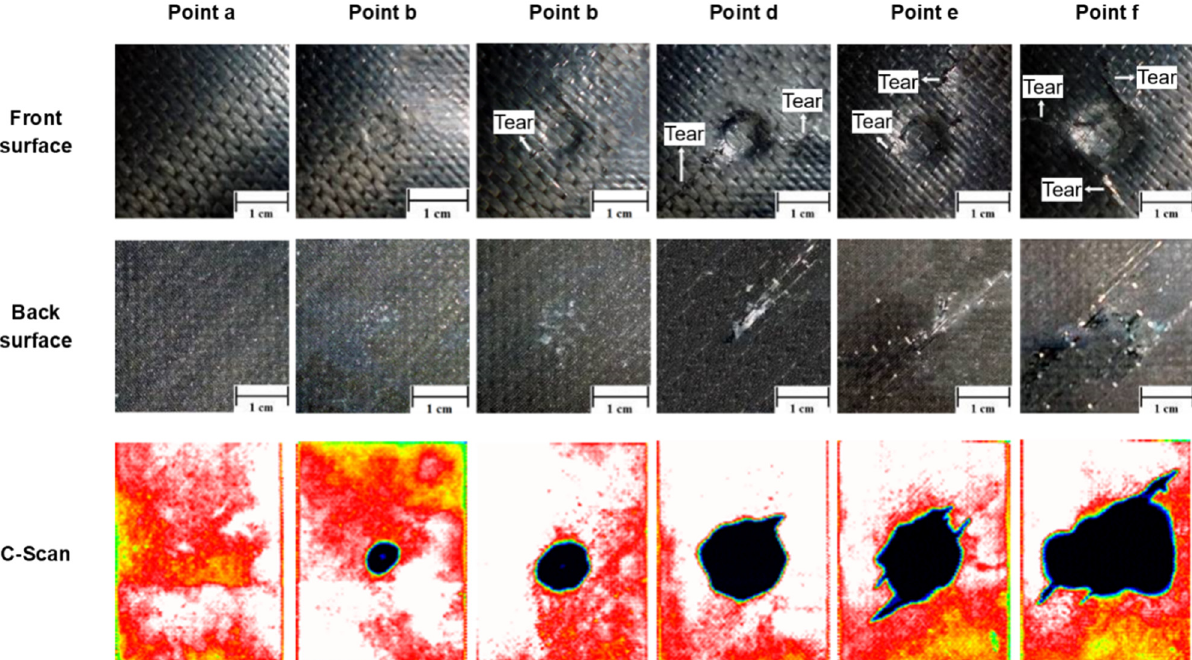
Figure 3: The corresponding optical photographs and ultrasonic C - scan images of specimens under di ff erent loadings ( points a – f in Figure 2 ) ,